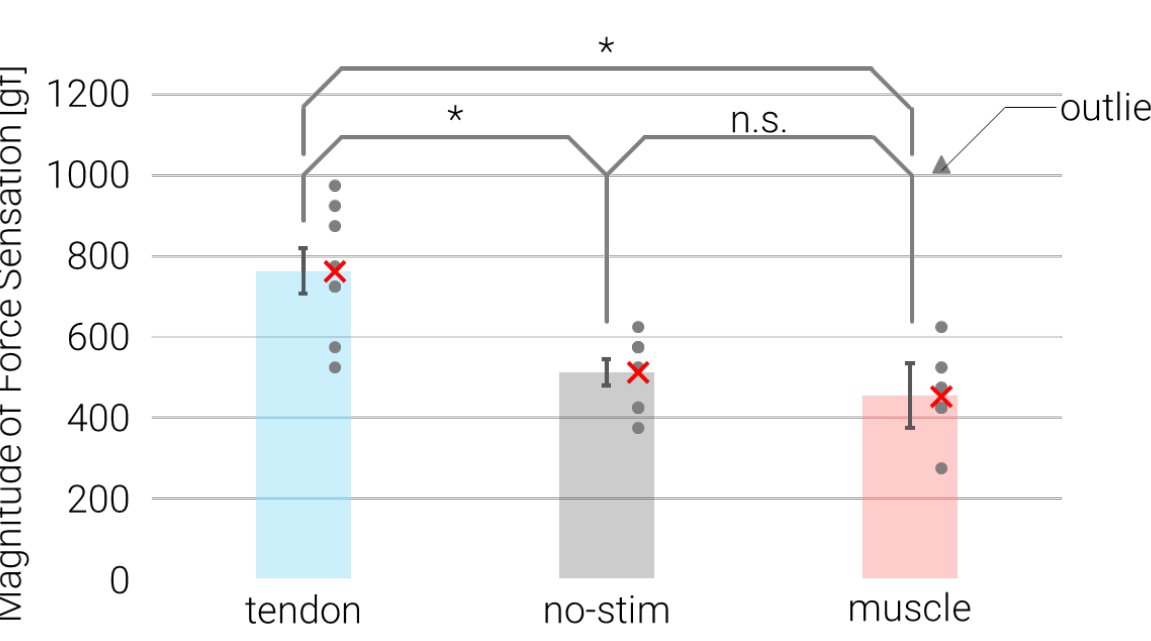
Figure 4. Bar plots of the magnitude of force sensation under the three conditions. The scatter plots show each participant’s data, some of which are showed overlapped each other. A triangle point in the scatter plot means the outlier. The error bar means standard error. A single star (*) in the figure means significance at 5% level, and the n.s. means no significance.